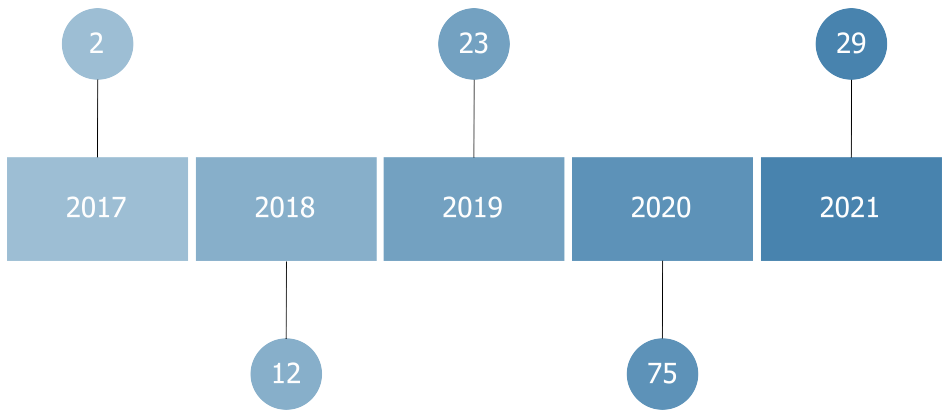
Figure 2. Map with the number of articles by country. A dark color indicates a higher number of published articles.